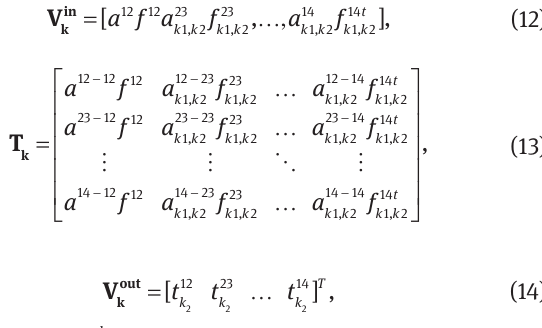
= h = 1.6 d , and h = 2 1 3 2